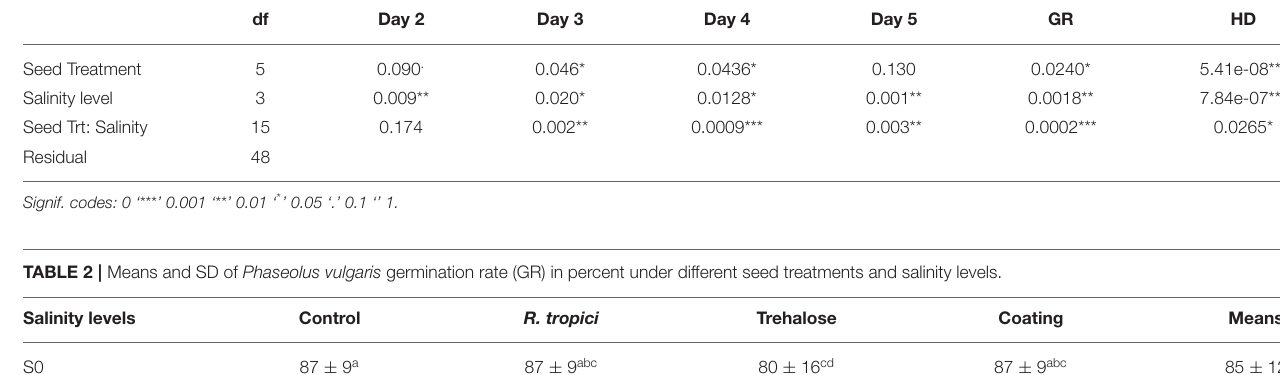
TABLE 1 | ANOVA table of the evolution of germination throughout the experience, germination rate (GR), and hypocotyl diameter (HD) in early germination test. df Day 2 Day 3 Day 4 Day 5 GR HD Seed Treatment 5 0.090 . 0.046* 0.0436* 0.130 0.0240* Salinity level 3 0.009**